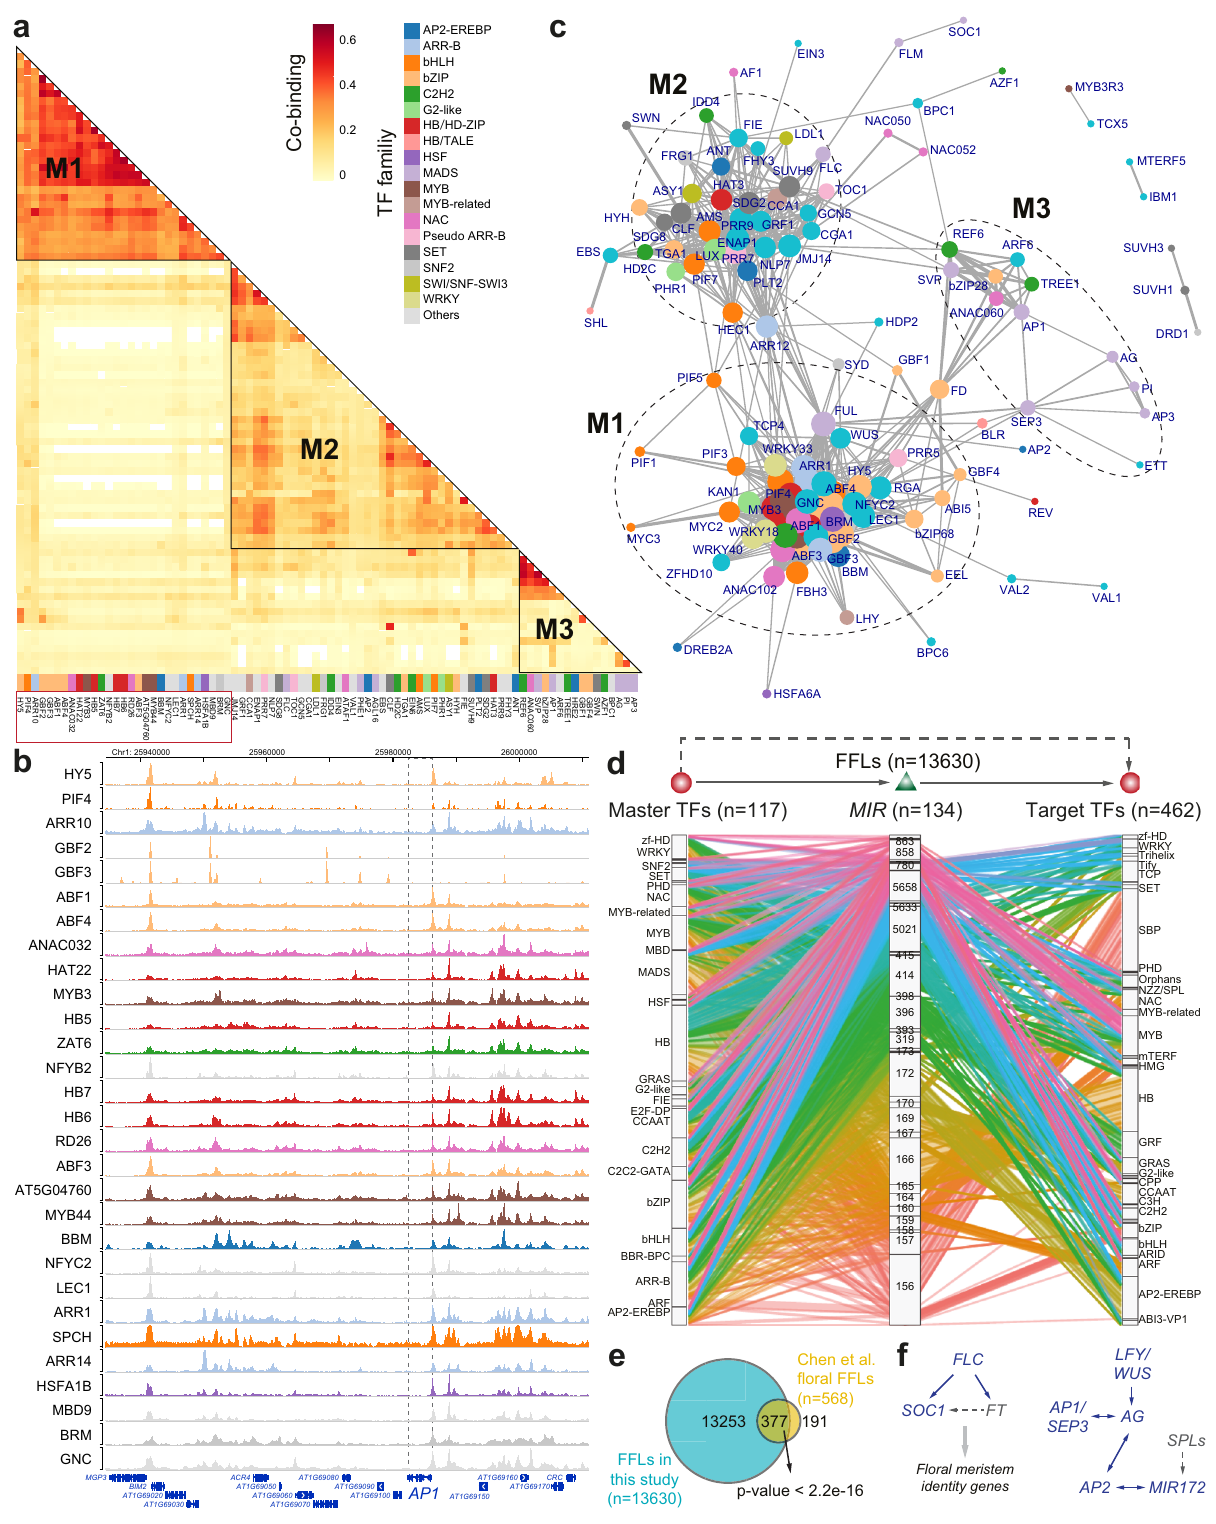
target genes (Fig. 3a and Supplementary Fig. 7), as exempli fi ed includes MADS TFs response for fl ower development 31 . Interestingly, around the APETALA1 ( AP1 ) gene locus (Fig. 3b and Supple- mentary Fig. 8). We organized the pairwise TF co-association into networks with TFs as nodes and their co-binding possibility as edges (Fig. 3c and Supplementary Fig. 9). We observed three dominant co-associated TF modules (M1-M3). M1 consists reg- ulators from TF families of bZIP, bHLH and MYB, while M3 NATURE COMMUNICATIONS| (2022) 13:3413